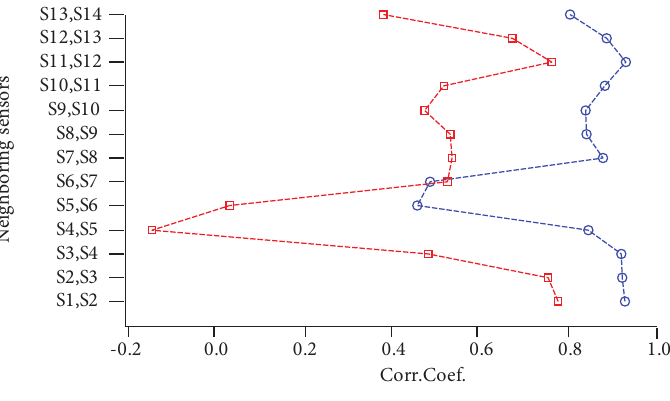
Figure 13. Linear correlation coefficient diagram for hot wire sensors.